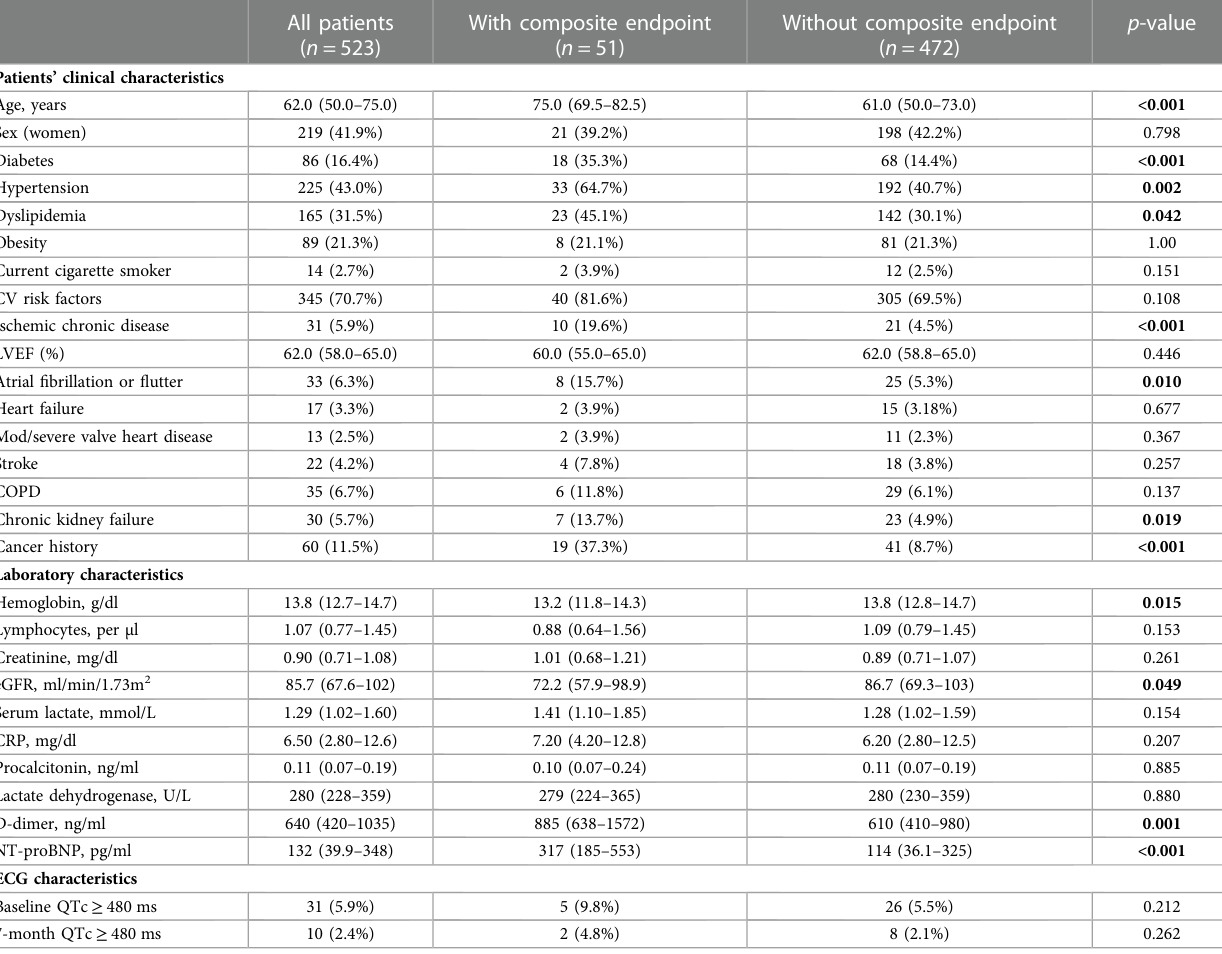
p -value All patients With composite endpoint Without composite endpoint ( n = 523) ( n = 51) ( n = 472)